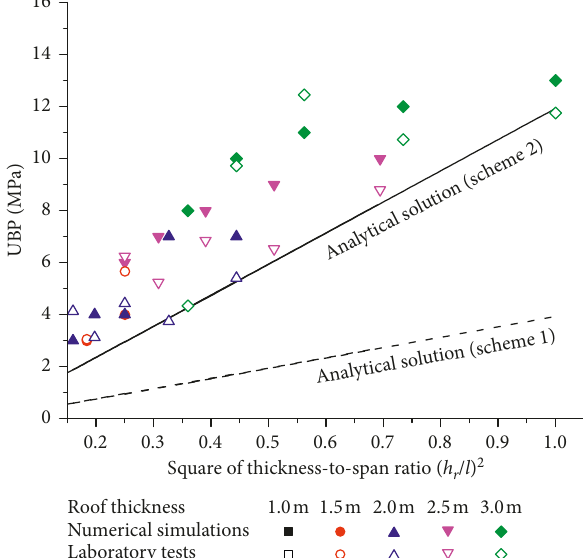
Figure 16: The relationship between the ultimate bearing pressure and the square of the thickness-to-span